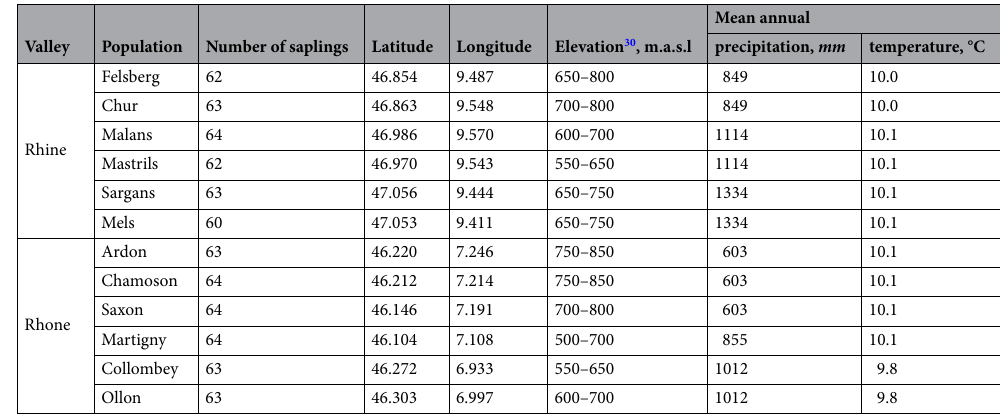
Table 3. Geographic and climate data for the period 1981–2010 a for beech populations used in the study. a Taken from the METEO SWISS stations located near the populations (distance ≤ 10 km).